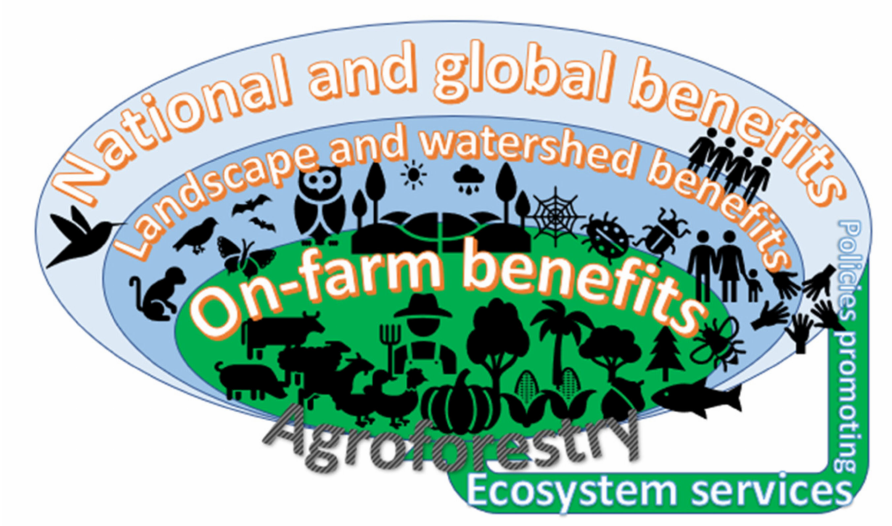
Figure 1. Agroforestry-based ecosystem services are human benefits achieved beyond the farm scale from the way trees on farm interact with soil and water, carbon storage, and biodiversity and of the cultural/relational aspects of landscapes with partial tree